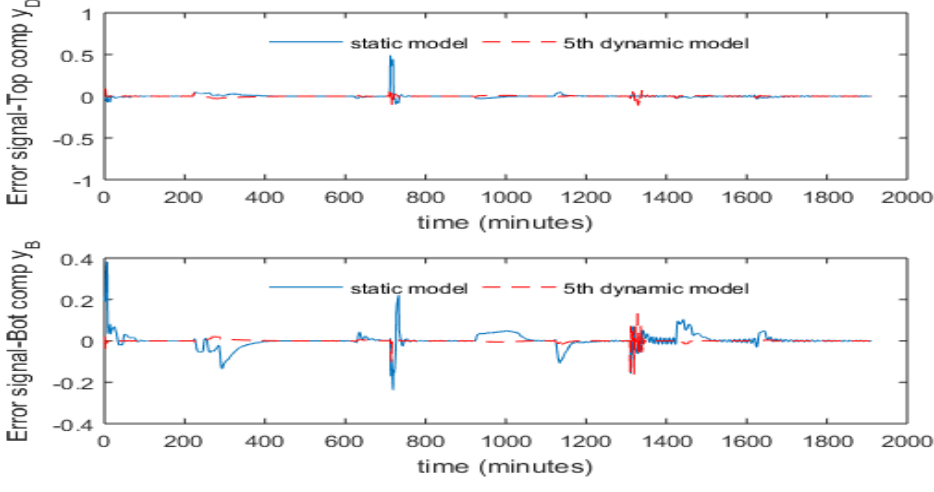
Figure 8. Model prediction errors.